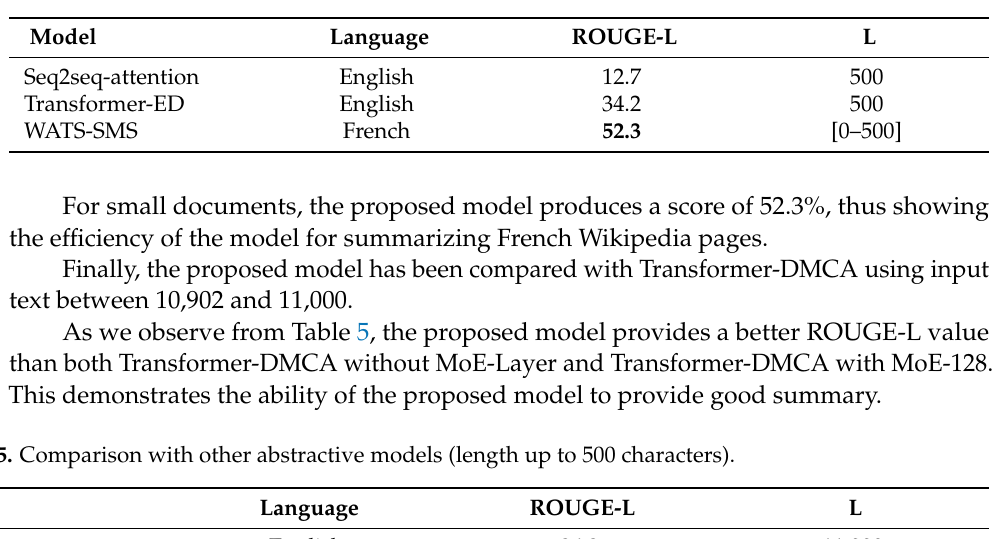
Table 4. Comparison with other abstractive models (length up to 500 characters).